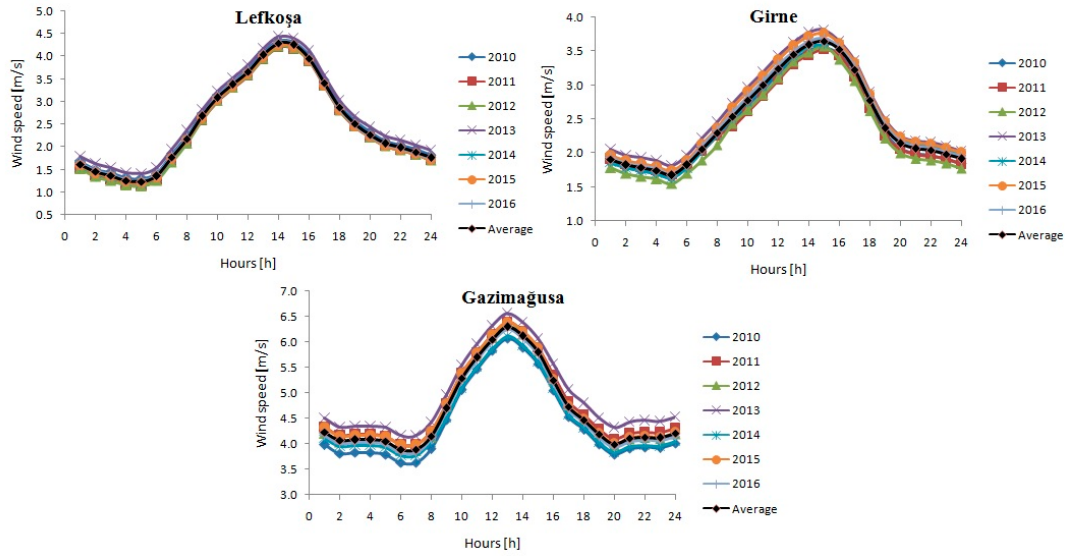
Figure 4. Hourly variation of the mean wind speed at a 10 m height.